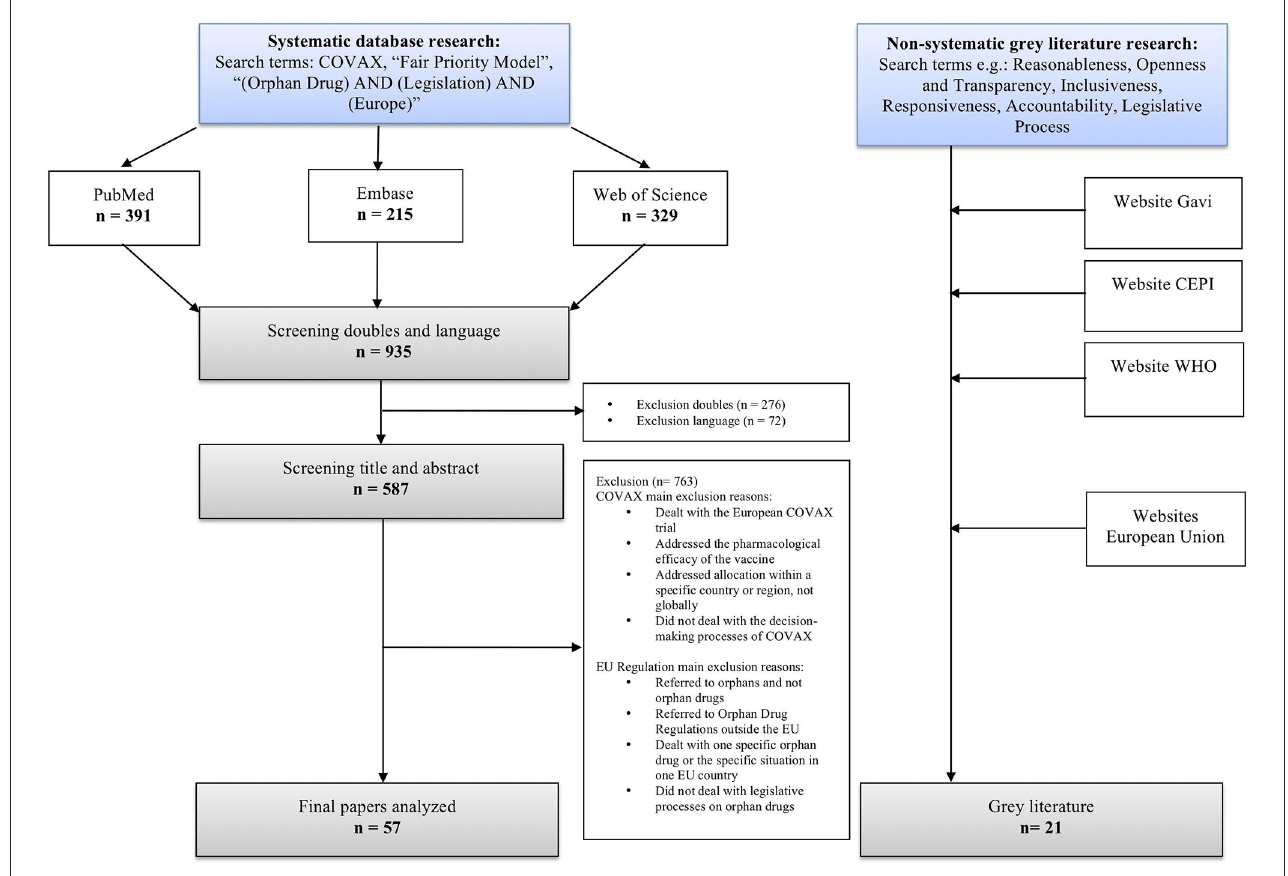
FIGURE3 Flowchart of systematic and non-systematic literature search on May 15,